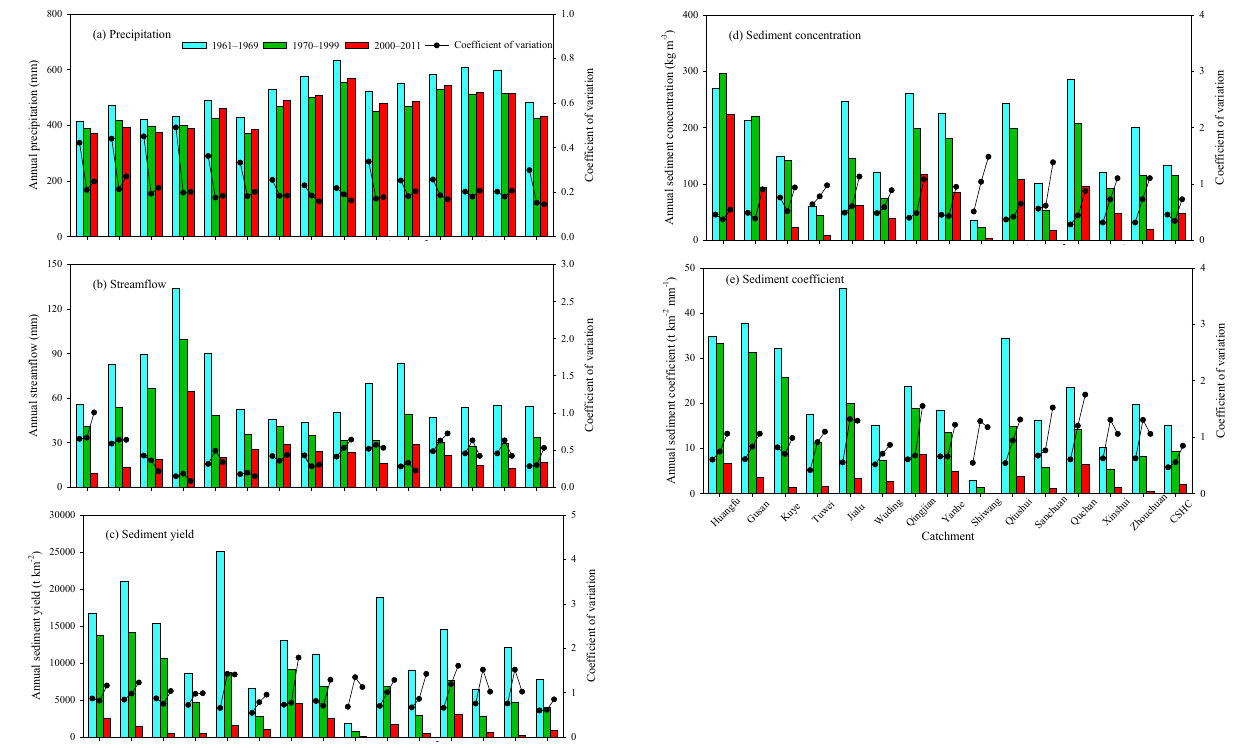
Figure 7. The changes in (a) precipitation, (b) streamflow, (c) sediment yield, (d) sediment concentration, and (e) sediment coefficient during different stages (1961–1969, 1970–1999, and 2000–2011). Table 3. The linear regression equations between the square root of specific sediment yield and annual precipitation ( during three stages (1961–1969, 1970–1999, and